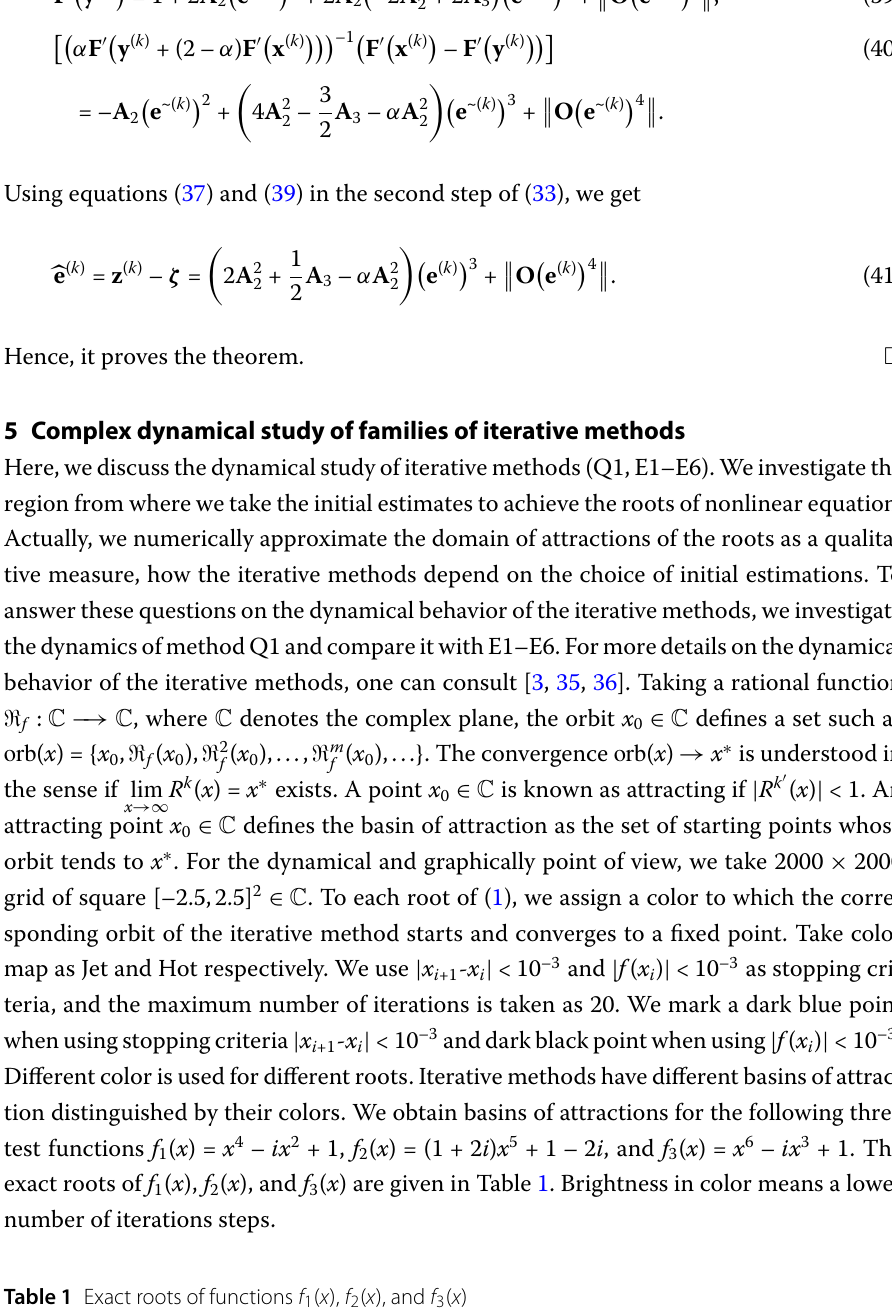
Table 1 Exact roots of functions f 1 ( x ), f 2 ( x ), and f 3 ( x )